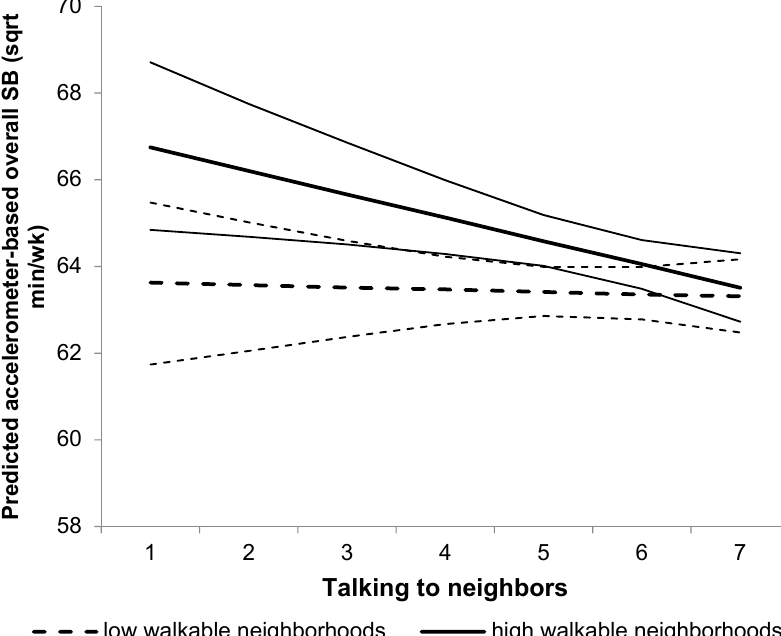
Figure 3. Interaction between talking to neighbors and neighborhood walkability for the predicted overall SB. Plot represents overall SB levels (square root transformed variable) for high-walkability (thicker full line) and low-walkability (thicker dashed line) neighborhood residents, and their confidence intervals (thinner lines).